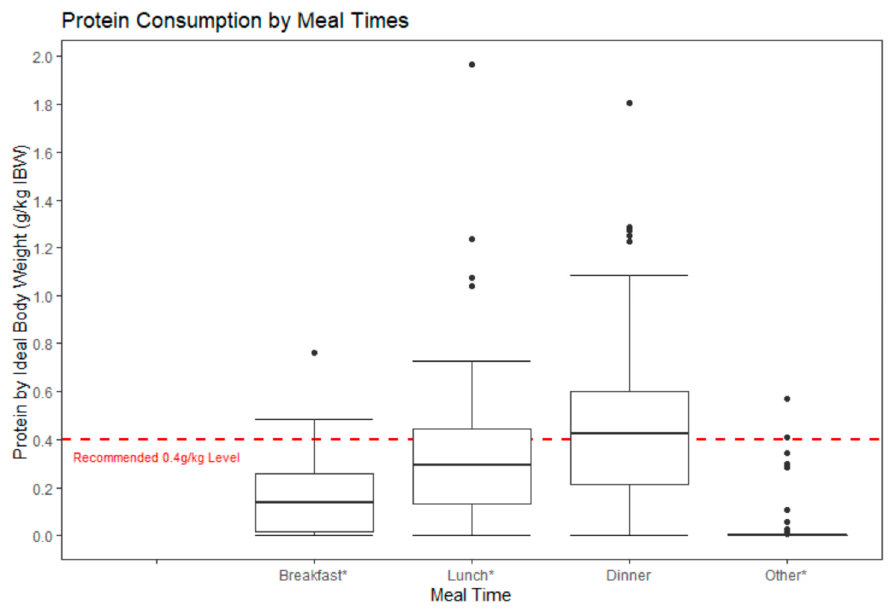
Figure 2. Protein consumption by meal time (g/kg IBW). * indicates statistical significance ( p -value < 0.05). Table 5. Protein consumption by meal time ( n = 92).